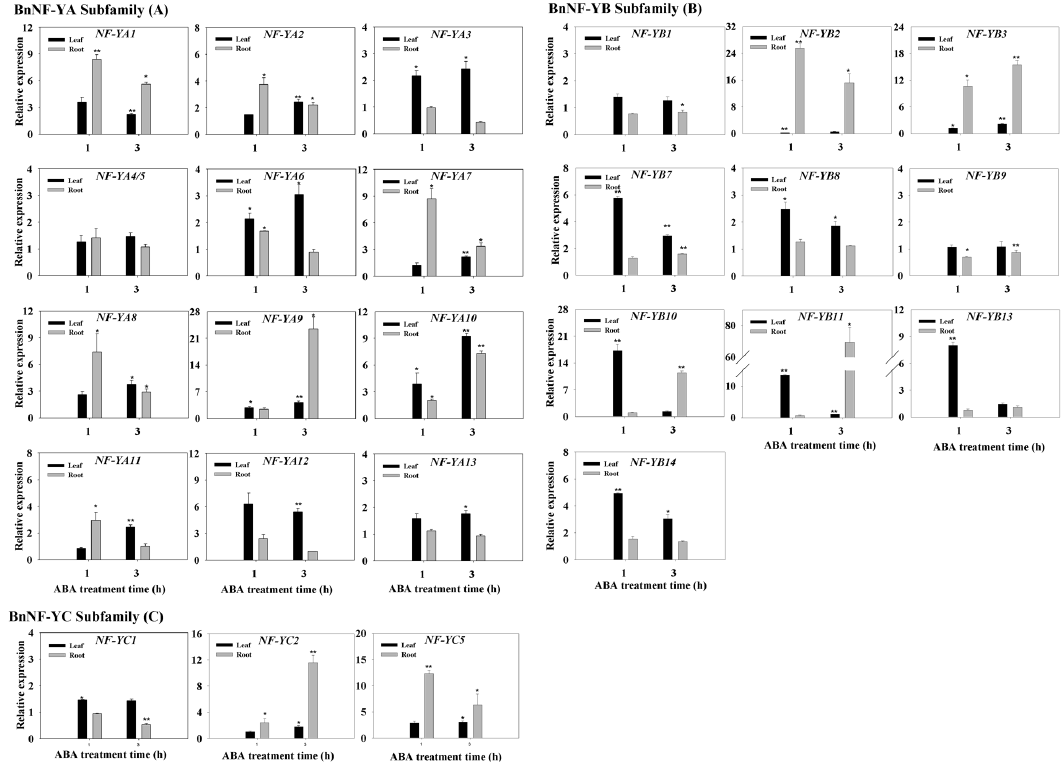
Figure 3. Expression pattern of the BnNF-Y genes in the leaves and roots of plants exposed to 100 m M ABA. Transcript levels of BnNF-Y ( A), BnNF-YB (B), and BnNF-YC (C) genes after exposure to 100 m M ABA. Three-week-old canola plantlets were treated with 100 m M ABA for 1 h and 3 h. Total RNA was extracted from leaves and roots for quantitative PCR (qRT-PCR) analysis. Transcript levels of each BnNF-Y were first normalized to those of the housekeeping gene 18S and then compared to levels at each time point in the control. Each data point represents the mean 6 SE of three independent experiments. Significant differences between treated samples and untreated controls (same tissue only) are indicated by a single (P , 0.05) or double (P , 0.01) asterisk, according to Dunnett’s method of one-way ANOVA in SPSS. Expression levels in untreated samples (CK, 1-h or 3-h leaf and root samples) were arbitrarily set to 1.0.